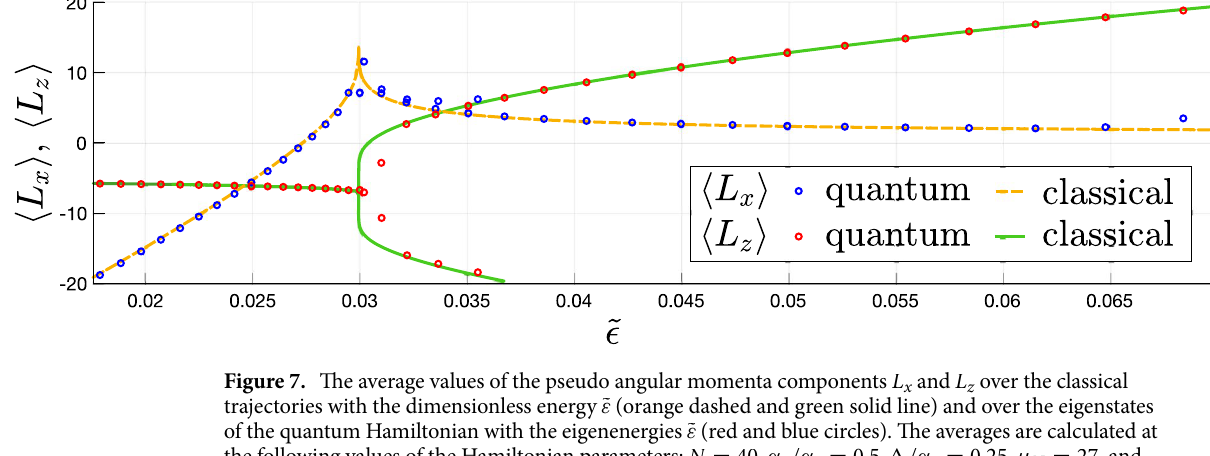
ε (orange dashed and green solid line) and over the eigenstates ˜ ε (red and blue circles). The averages are calculated at ˜ 40 , α 2 /α 1 27 , and 0.5 , �/α 1 0.25 , µ N = = = =